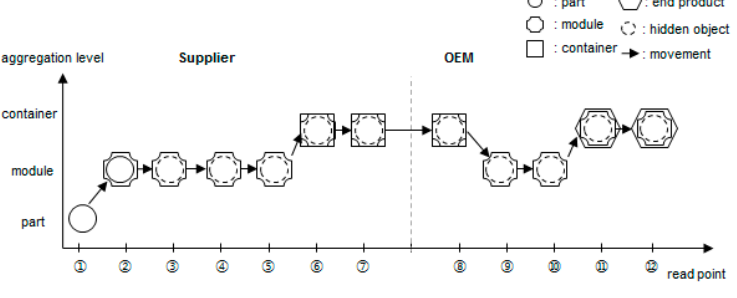
Figure 4. Typical object flow in the supply chain.